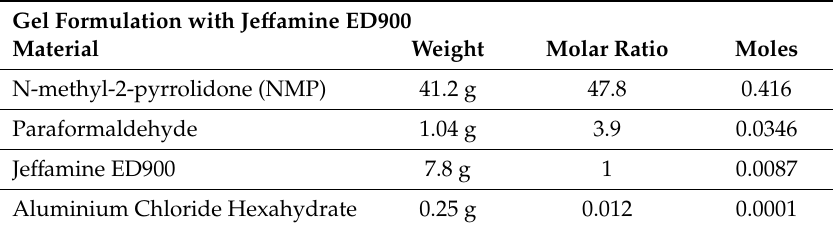
Table 2. Gel and liquid formulations with NMP and Je ff amine ED900.